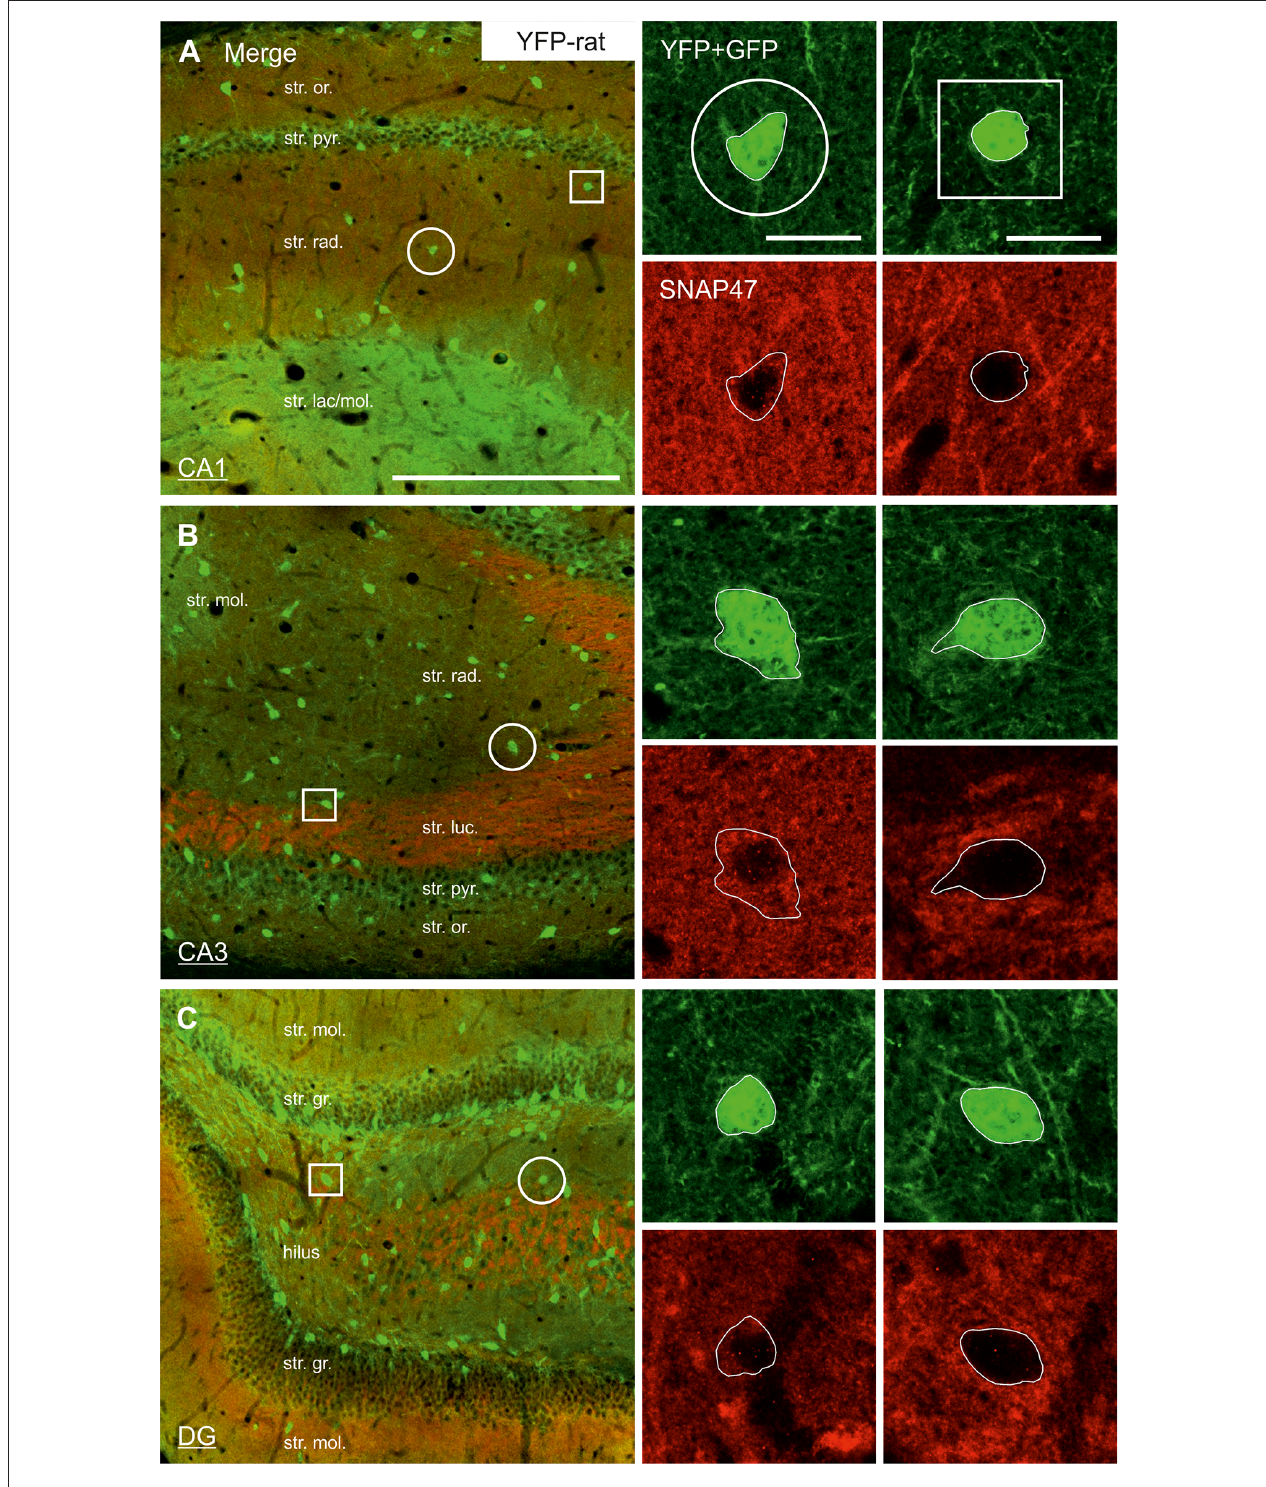
FIGURE 5 | Low SNAP47 expression in YFP-positive INs in the hippocampus of VGAT-Venus(YFP) transgenic rats. (A–C) High-power confocal images of double immunolabeling for YFP and SNAP47 in the CA1 (A) , the CA3 area (B) and the DG (C) of VGAT-Venus(YFP) transgenic rats. Insets on the right show SNAP47-positive INs (circles, first column) with weak cytoplasmic labeling (red pseudocolor, bottom images) in the YFP-positive cell bodies (green, top images) and SNAP47-negative INs (squares, second column). Scale bars represent, (A–C) , 250 µ m; insets, 20 µ m.